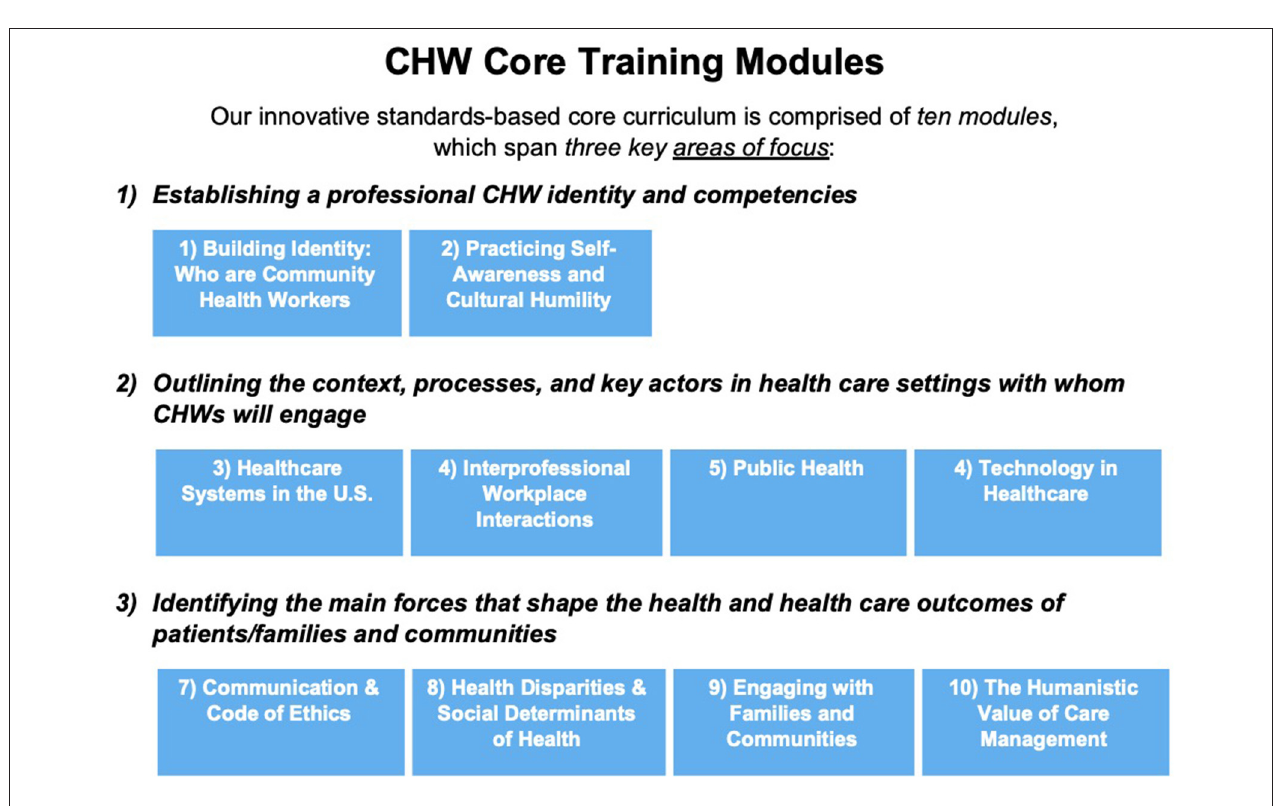
FIGURE 3 | CDU CHW core training